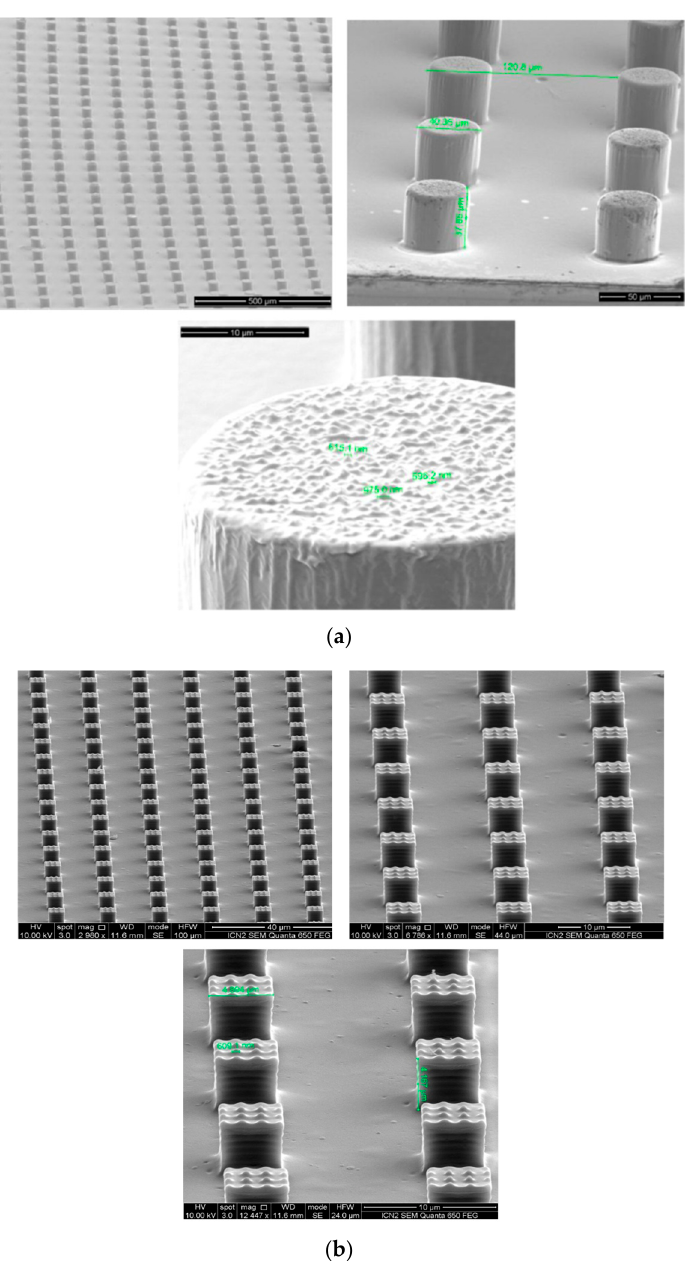
Figure 8. SEM micrographs of 3D hierarchical domains on the surface of PLA films at different magnifications: ( a ) black silicon nanostructures on spherical micropillars [139]; ( b ) rectangular hierarchical nanostructured PLA nanocomposite surfaces [140]